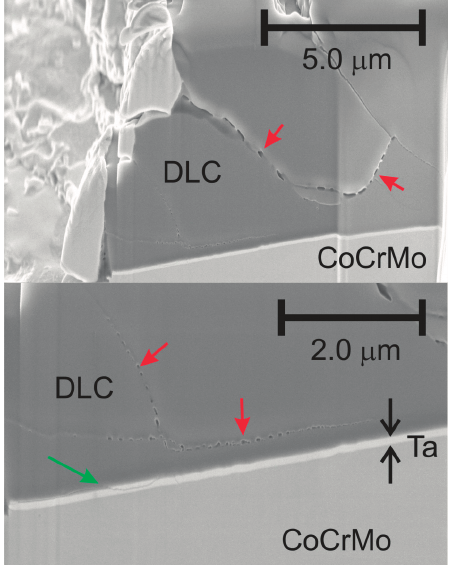
Figure 5. Focused ion beam (FIB) cross section on a defect edge after 100 million cycles. Red arrows: “Bubble-like” failures, green arrow: Crack exiting the